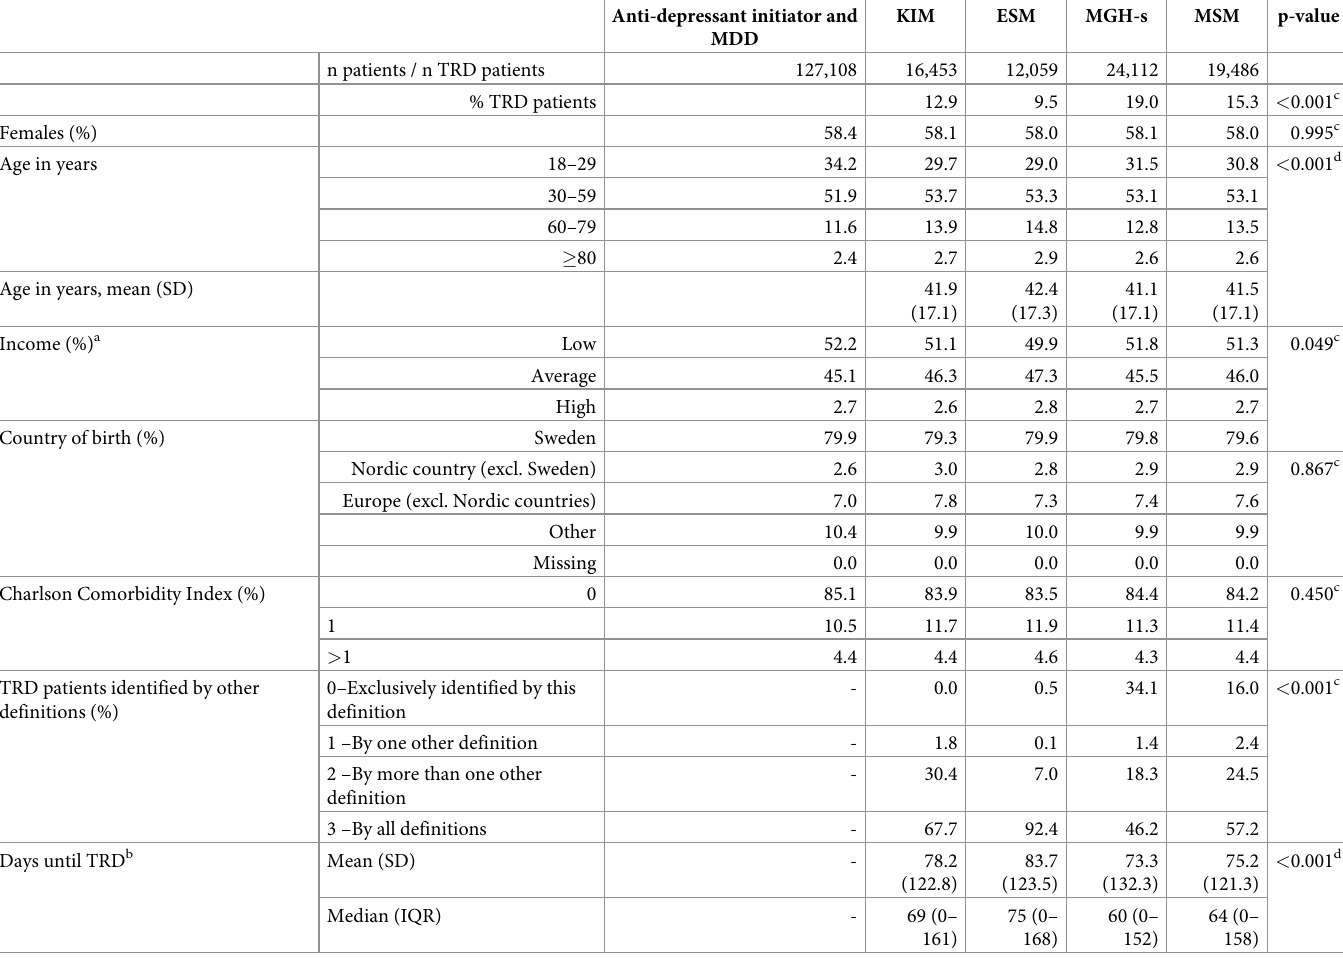
Table 1. Patient characteristics of the total cohort of major depressive disorder (MDD) and the patient groups established by the TRD definitions: Karolinska Insti- tutet Model (KIM), European Staging Method (ESM), Massachusetts General Hospital Staging Method (MGH-s), and Maudsley Staging Method (MSM). Anti-depressant initiator and